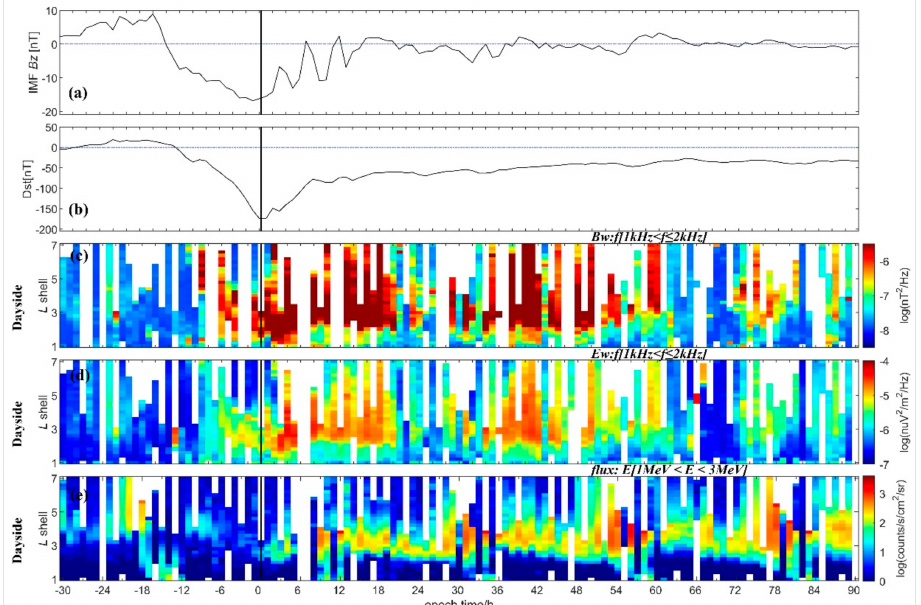
Figure 2. The variation of ionospheric extremely/very low frequency (ELF/VLF) wave intensity and energetic electron fluxes during the geomagnetic storm that occurred from 25 to 29 August 2018. ( a ) IMF Bz in the GSM coordinates, ( b ) Dst index, ( c , d ) the power spectral density (PSD) values of the magnetic and the electric field at frequency range from 1 to 2 kHz, and ( e ) the energetic electron fluxes at energy level from 1 to 3 MeV. Data were integrated by the superposed epoch method [9], and the vertical solid line denotes the reference time t 0 that is the time of Dst minimum on 06:00 to 07:00 UT on 26 August 2018. The y axis in ( c – e ) indicates the L shell from 1 to 7. The white blank regions denote data gaps.